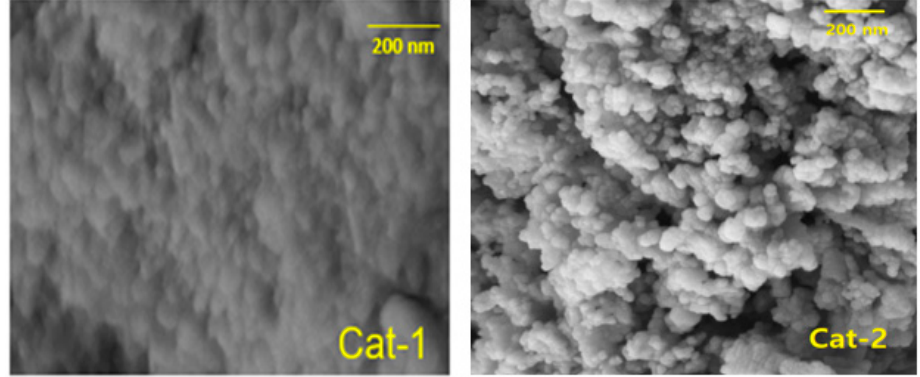
Figure 3. FESEM images of fresh catalysts.